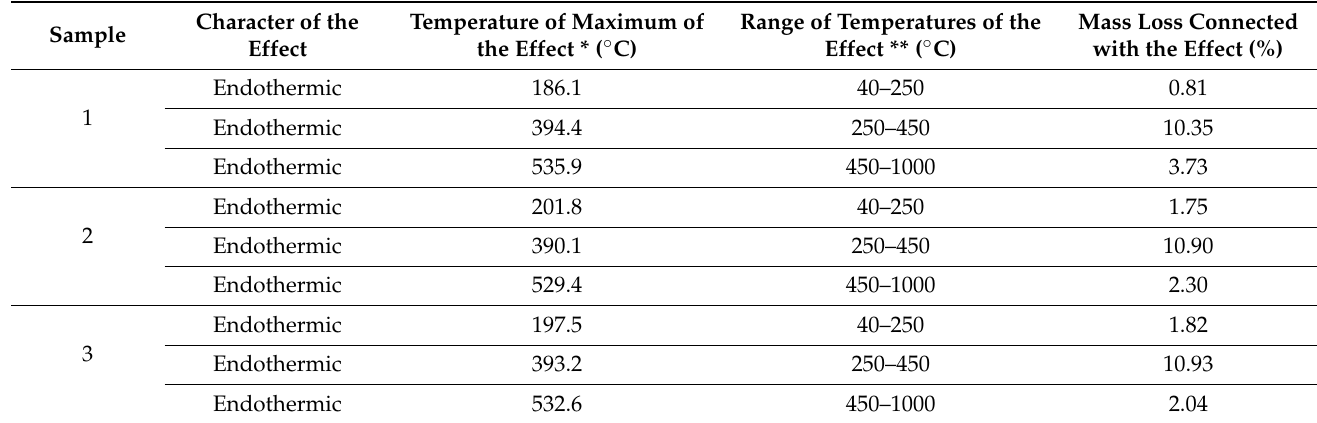
Figure 4. Thermogravimetric analysis of the studied samples with a loss of mass in a specific range of temperature. Table 3. Summary of the thermal effect and a loss of mass in a specified range